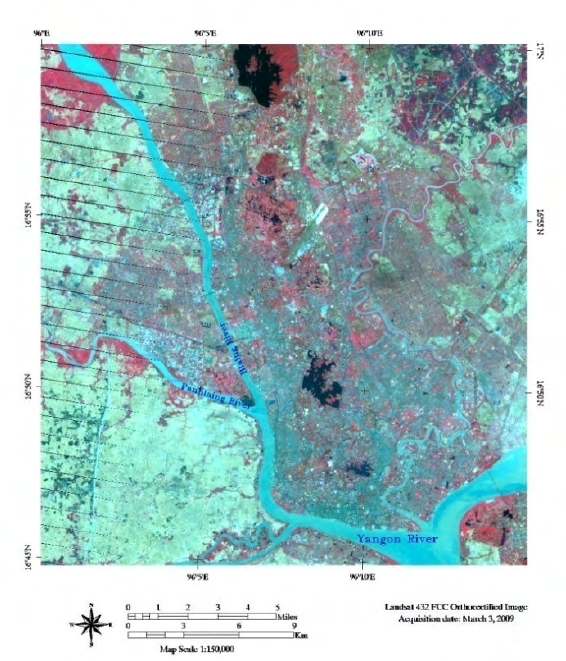
Figure 6. Landsat 432 Color Composite Ortho-rectified Image